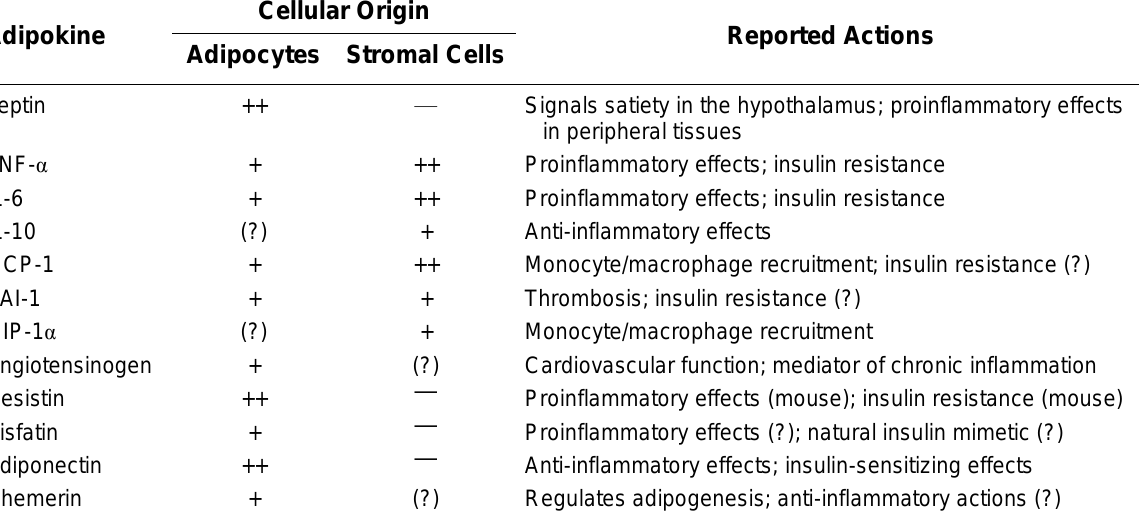
List of Selected Adipokines Secreted by Adipose